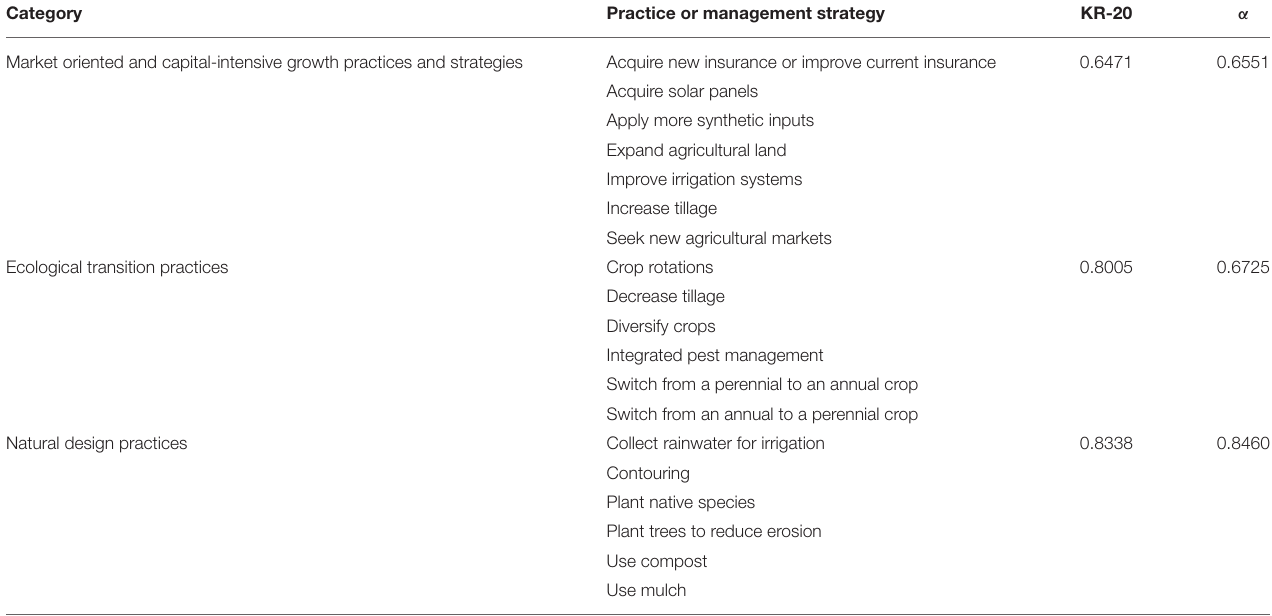
TABLE 3 | Categorized agricultural practices and management strategies to adapt to future extreme weather events like Hurricane Maria asked to